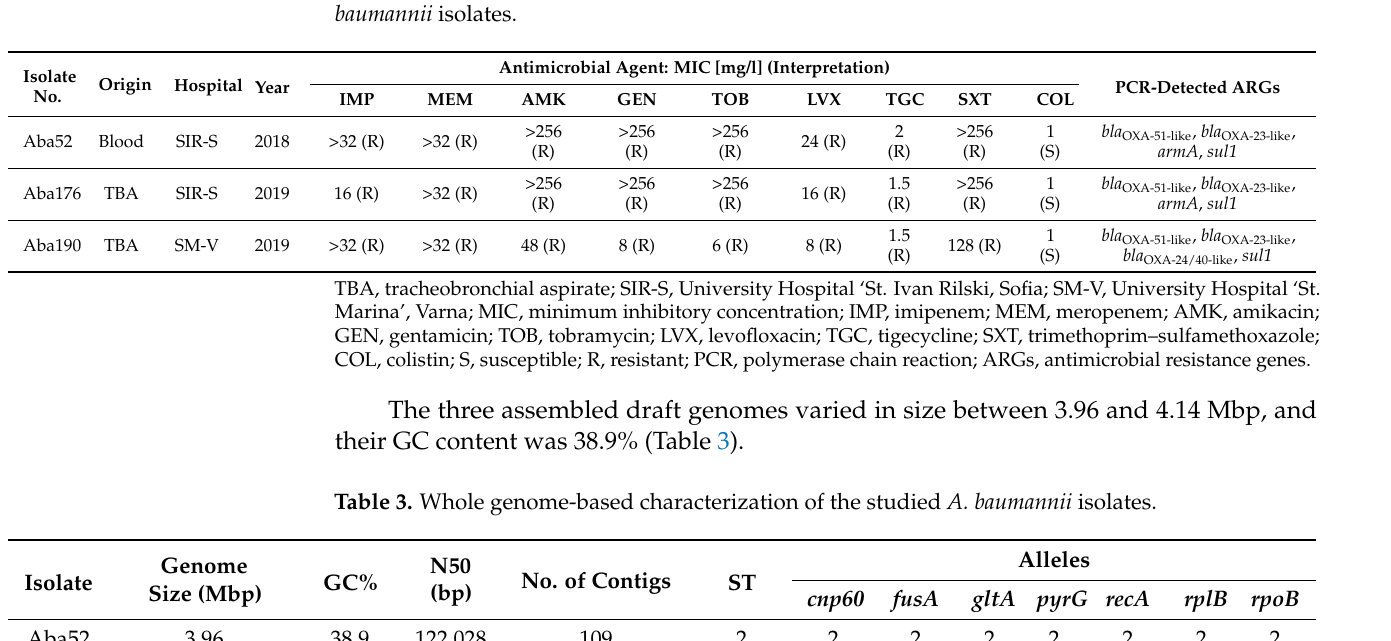
Table 2. Phenotypic and genotypic characteristics of the whole-genome sequencing-subjected A. baumannii isolates.